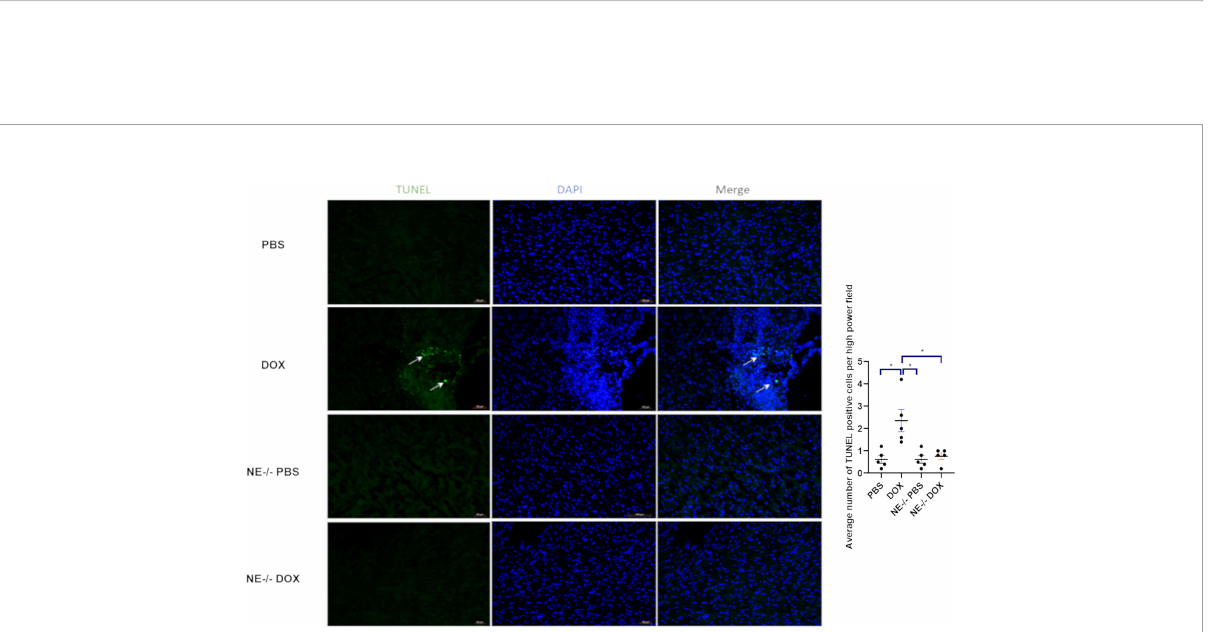
FIGURE 6 Effect of neutrophil elastase knockout (NE -/- ) on apoptosis in heart tissue following doxorubicin (Dox) treatment. Representative TUNEL staining images of heart sections 24 h after Dox treatment; Data are presented as mean ± SEM, n = 5 each, * p < 0.05, one-way ANOVA analysis with Tukey comparison was used to compare the